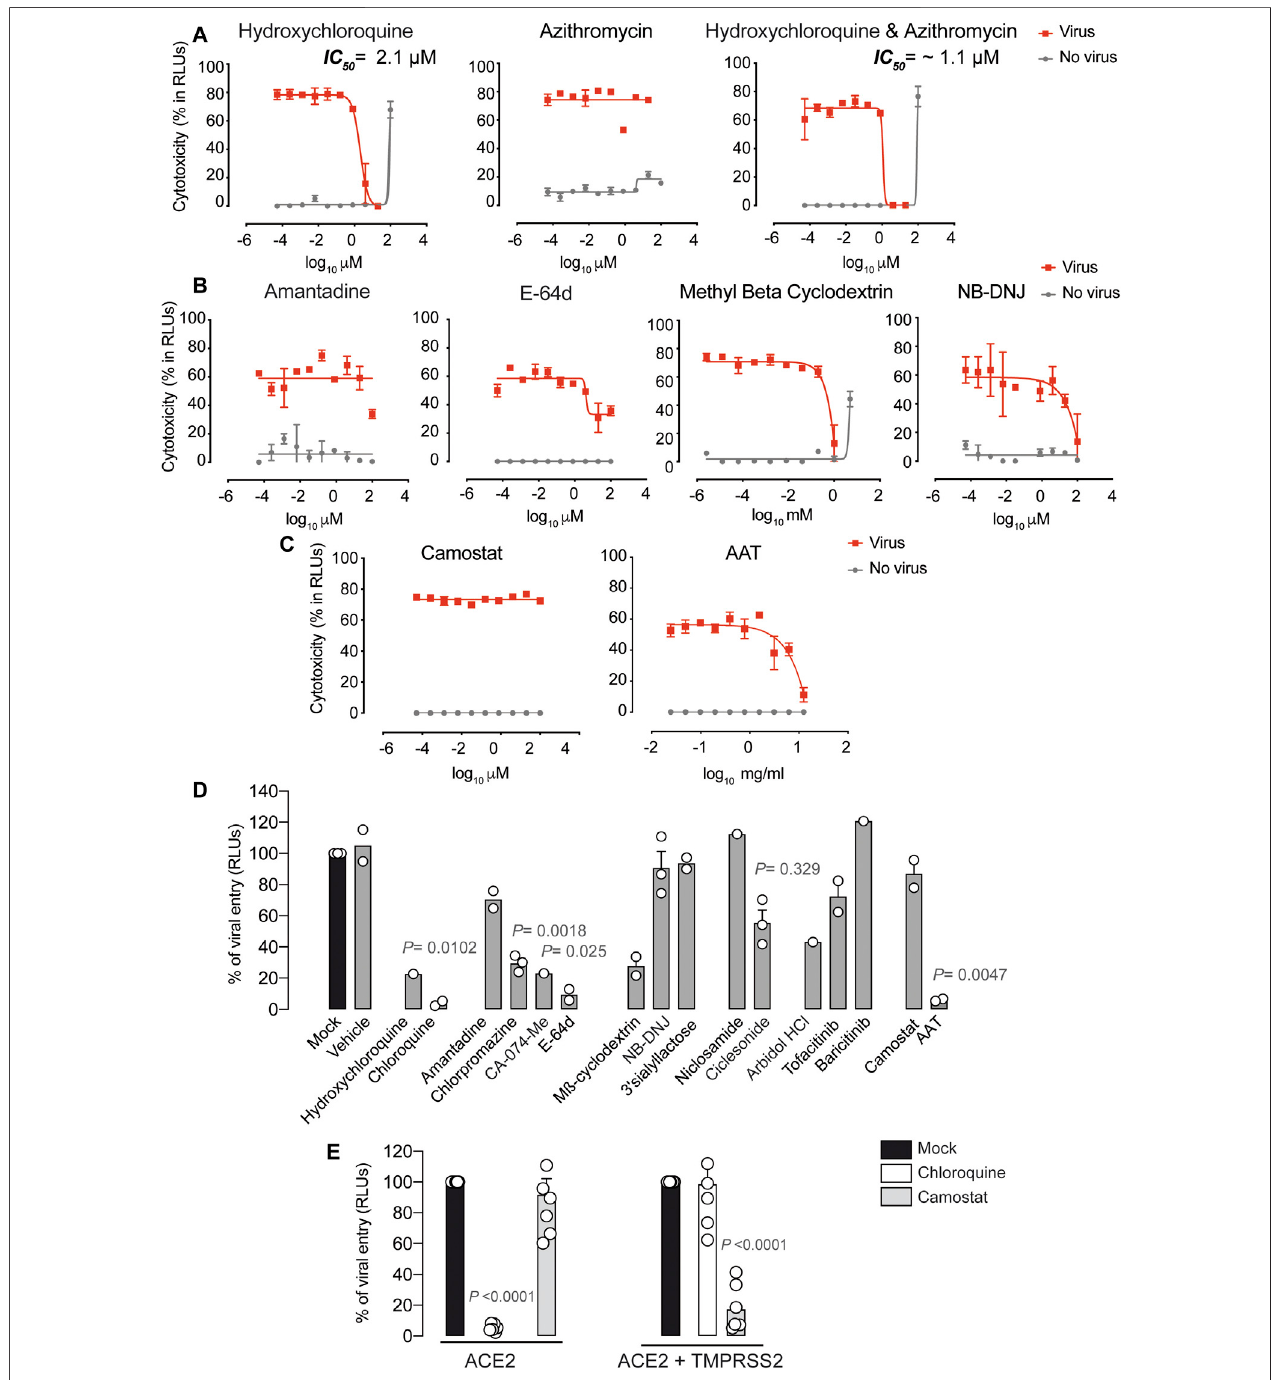
FIGURE1| AntiviralactivityofentryinhibitorsagainstSARS-CoV-2. (A) Antiviralactivityofhydroxychloroquineandazithromycin.Cytopathic effectonVeroE6cells exposed to a fi xed concentration of SARS-CoV-2 in the presence of increasing concentrations of hydroxychloroquine, azithromycin, and their combination. Drugs were used at a concentration ranging from 0.0512 nM to 100 µM. When combined, each drug was added at the same concentration. Non-linear fi t to a variable response curve from one representative experiment with two replicates is shown (red lines), excluding data from drug concentrations with associated toxicity. The particular IC 50 value ofthisgraph isindicated. Cytotoxic effect onVeroE6cells exposed toincreasingconcentrationsofdrugs intheabsenceofvirusisalso shown (greylines). (B) Cytopathic effect on Vero E6 cells exposed to a fi xed concentration of SARS-CoV-2 in the presence of increasing concentrations of amantadine, a